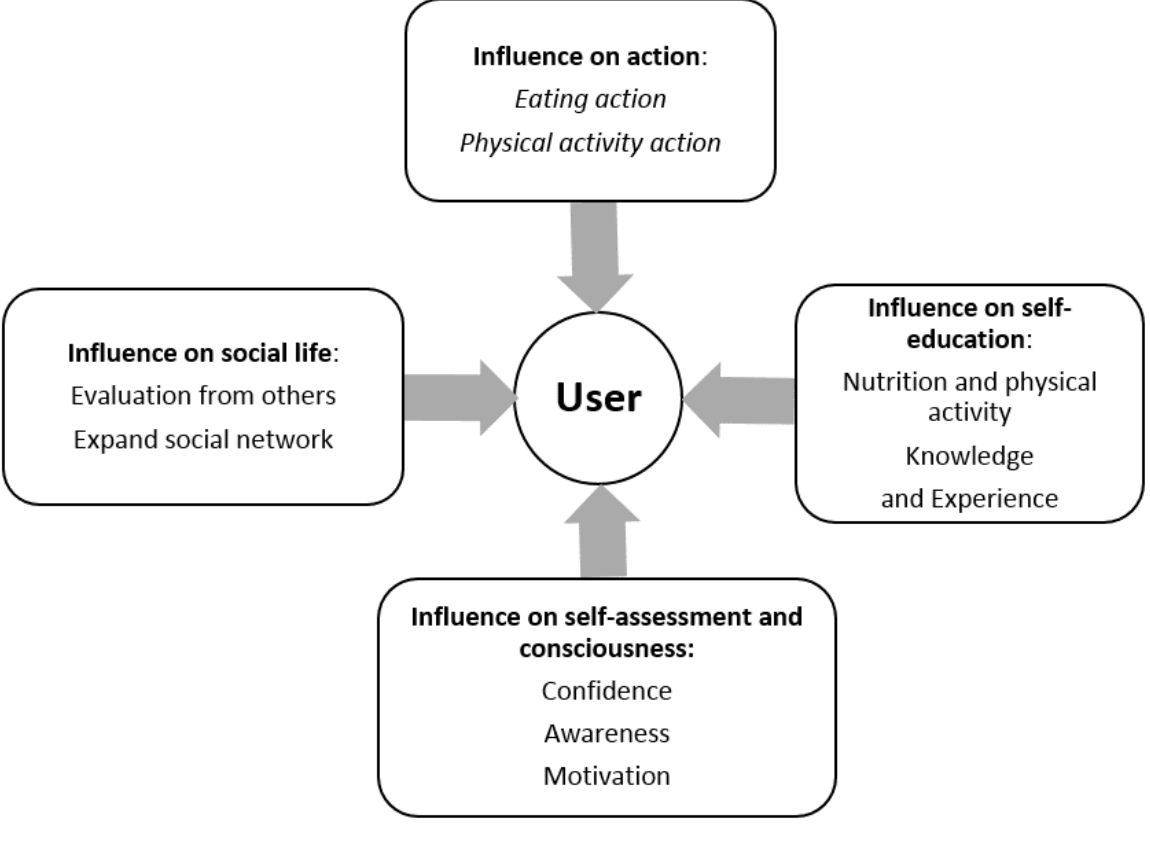
Figure 1. Qualitative influences perceived by app users based on focus groups. Four themes were summarized from focus group